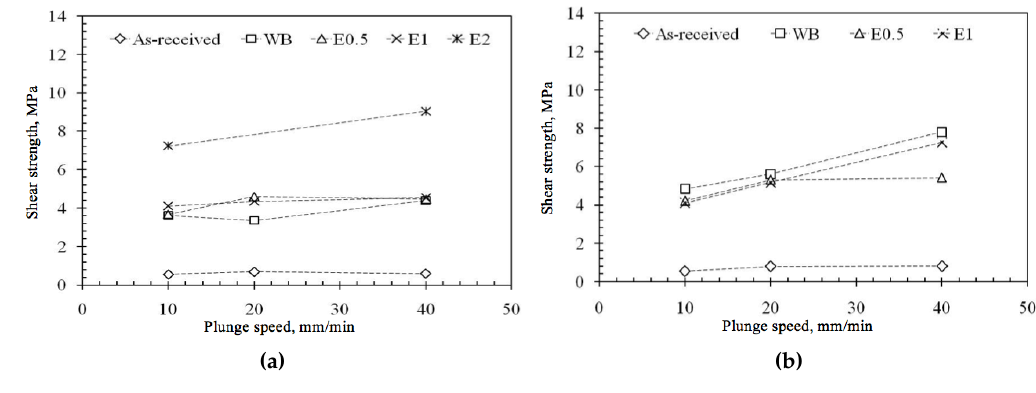
Figure 6. Effect of plunge speed on shear strength for different plunge depth. ( a ) Plunge depth: 0.4 mm and ( b ) plunge depth: 0.7